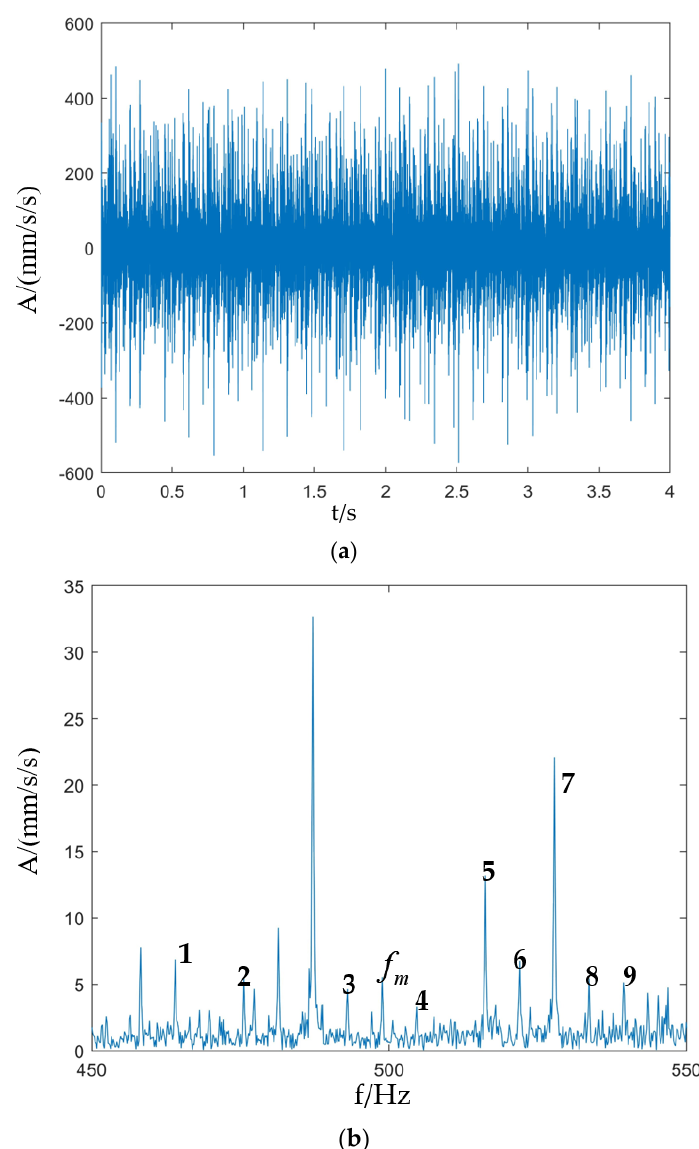
Figure 14. Vibration signal of the sun gear missing teeth and planetary gear missing teeth experiment: ( a ) Time domain waveform; ( b ) Fourier spectrum.